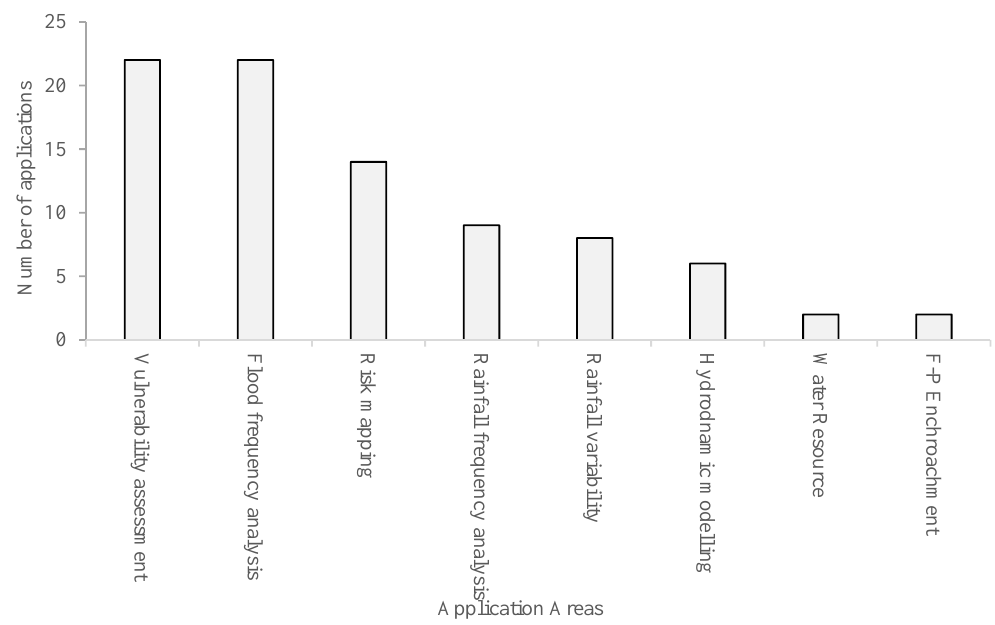
Figure 7. Flood studies in Nigeria showing specific application areas.